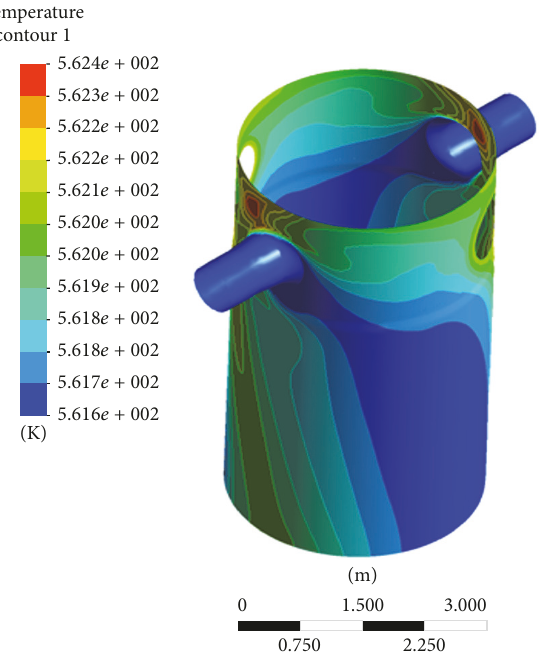
Figure 13: Temperature distribution of RPV wall at 102 s.